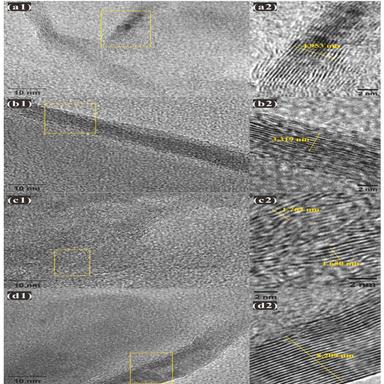
HRTEM micrographs of samples. a1 and a2: sample M1-1; b1 and b2: sample M2-2; c1 and c2: sample M2-1; d1 and d2: sample M2-3.